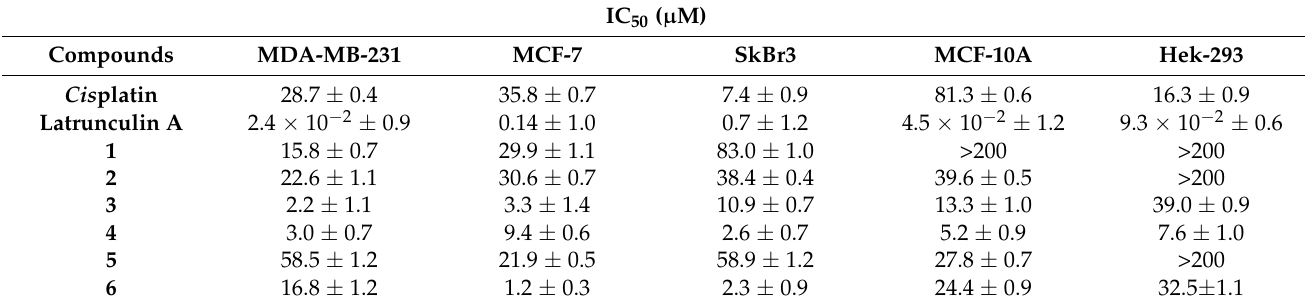
Table 3. IC 50 values of Au metal complexes ( 1 – 6 ), Cis platin and Latrunculin A, expressed in µ M, related to their anticancer activity against different breast cancer cells (MDA-MB-231, MCF-7 and SkBr3) and cytotoxicity against normal cells (MCF-10A and Hek-293). The means ± standard deviations are